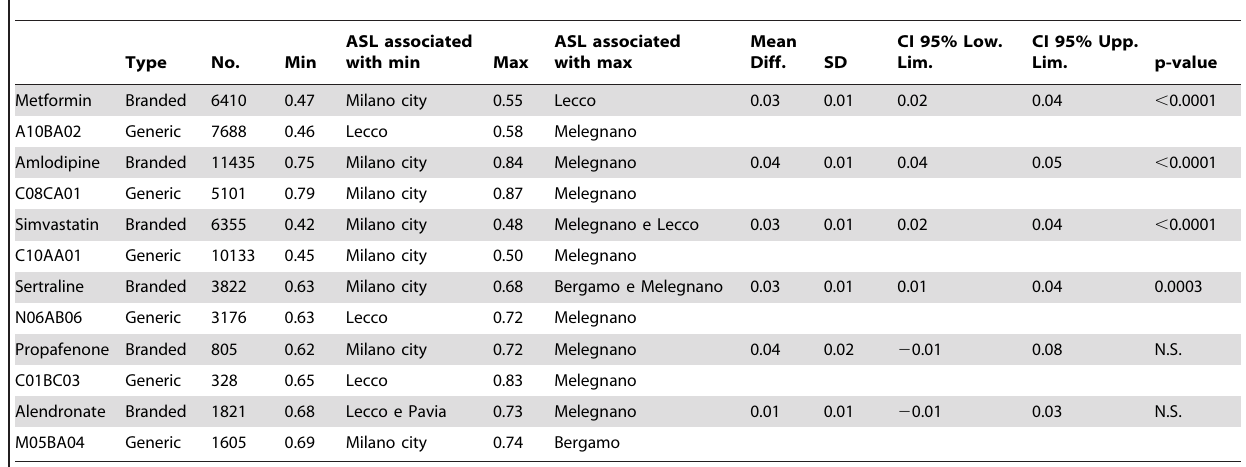
Table 3. Analysis of patients’ compliance for persistent patients (MPR - Medical Possession